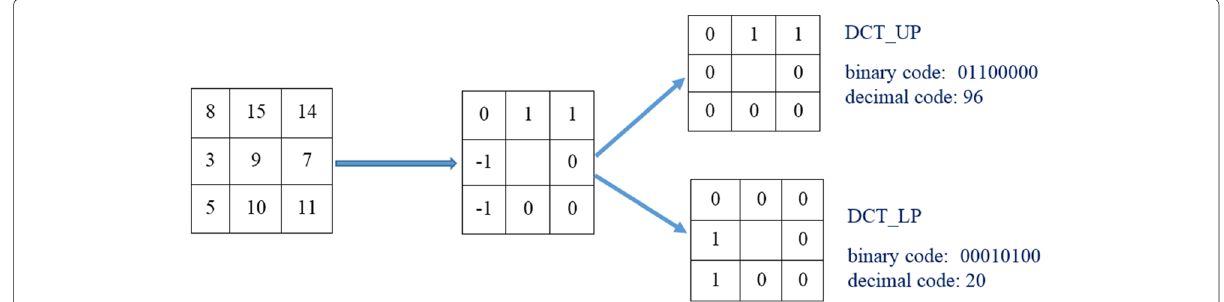
Fig. 6 An example of DCT calculation ( T = 3